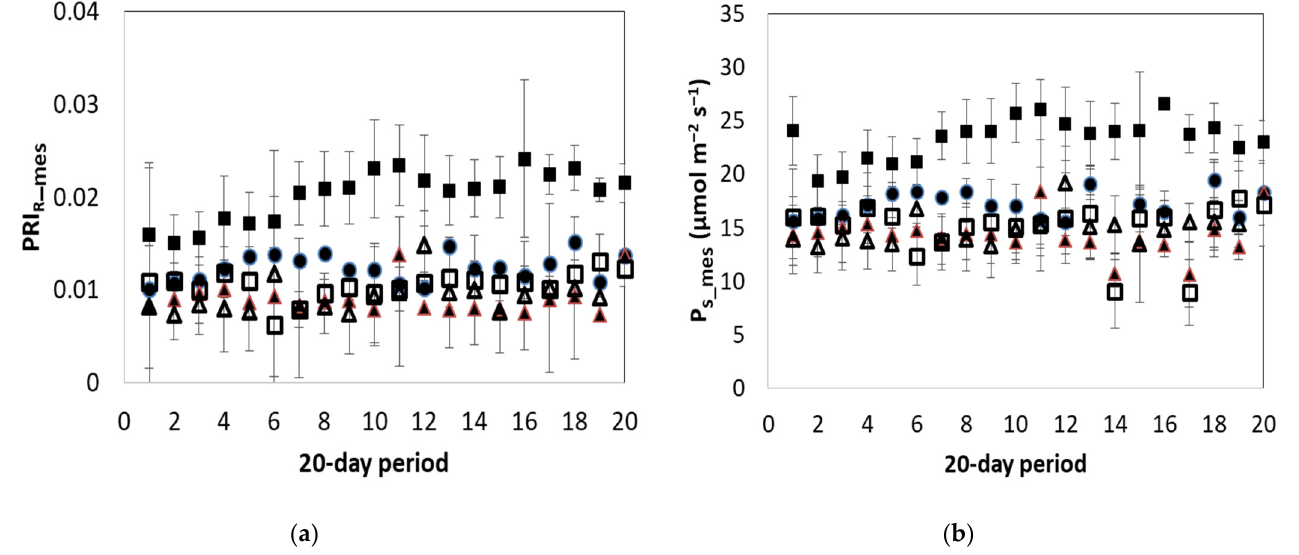
Figure 4. Daily mean values (and their standard deviation) of measured ( a ) photochemical reflectance index (PRI R_mes ) and ( b ) net photosynthesis rate (P s_mes ; μ mol m − 2 s − 1 ) observed for the different treatments. Solid circle: NoS; Empty triangle: LTS; Solid triangle: HTS; Solid square: LNS; Empty square: LWS.